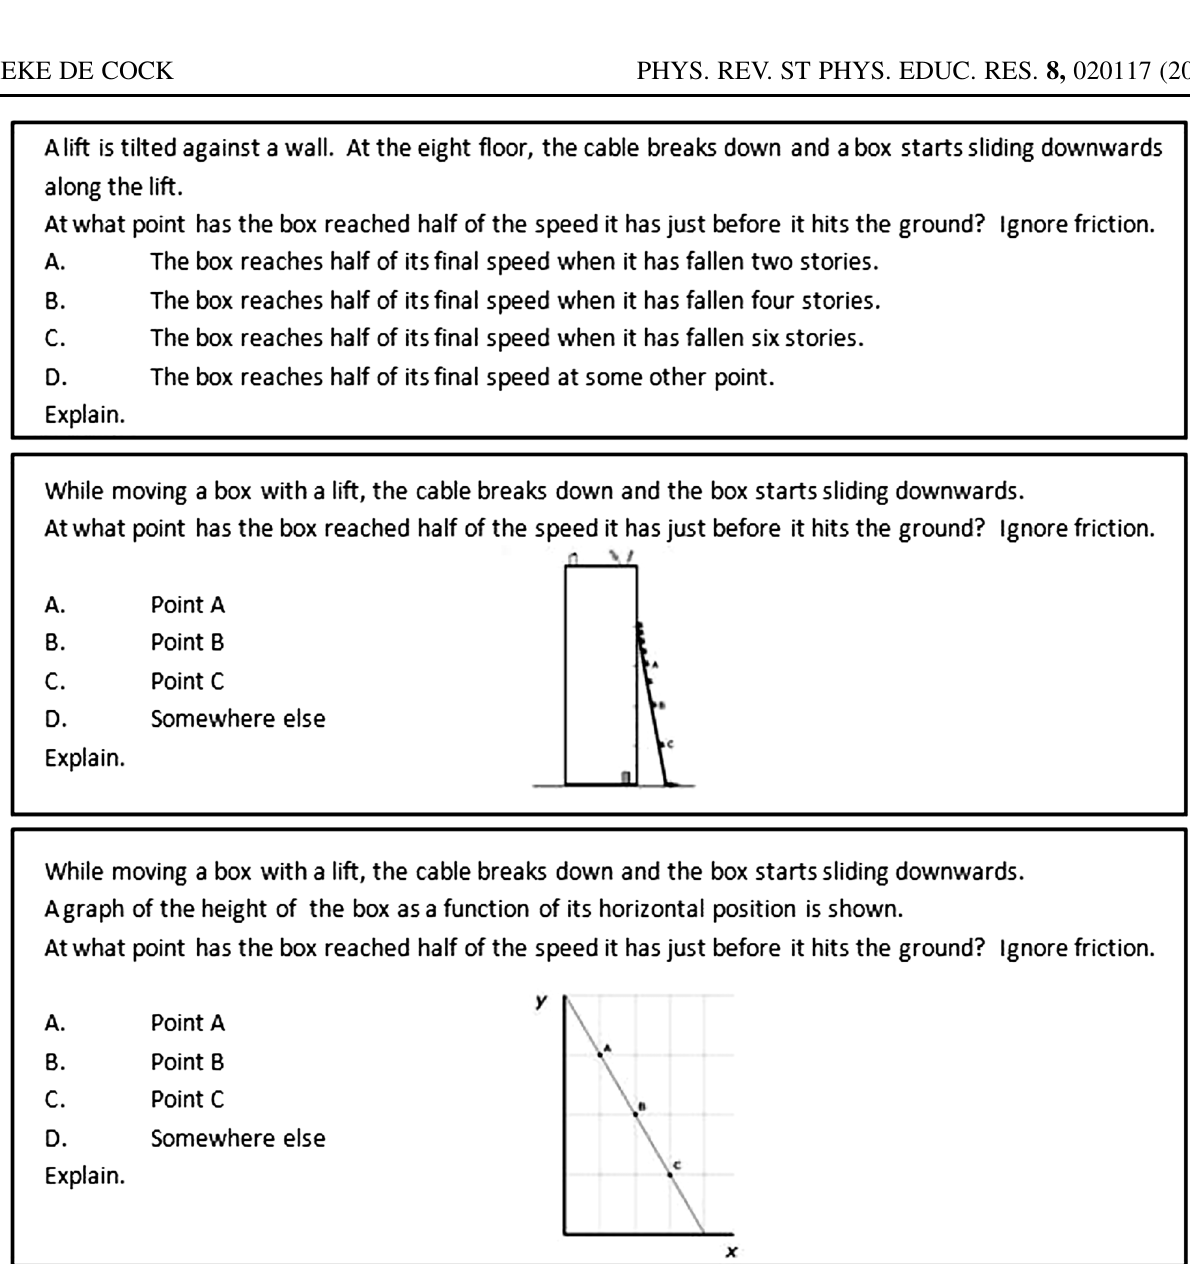
FIG. 3. Verbal, pictorial, and graphical representation of second